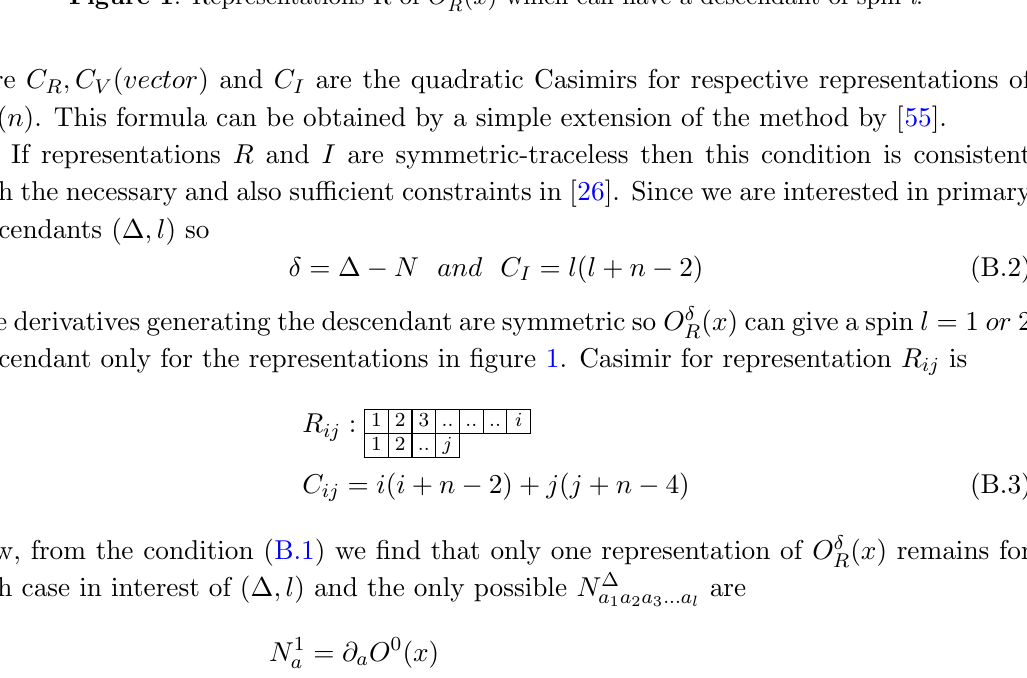
Figure 1 . Representations R of O (cid:14)